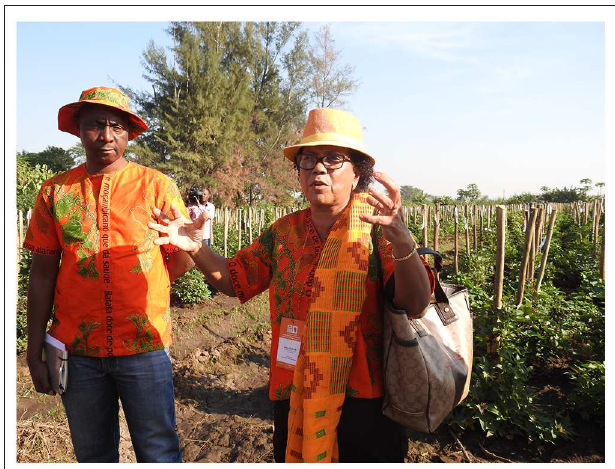
FIGURE 3 | Breeders José Ricardo (IIAM) and Maria Andrade (CIP) in front of 100 parent diallel crossing block in Mozambique (Credit J. Low).